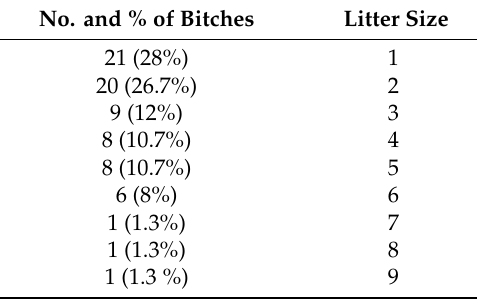
Table 3. Distribution of litter size of 75 * dystocia cases presented after unintended